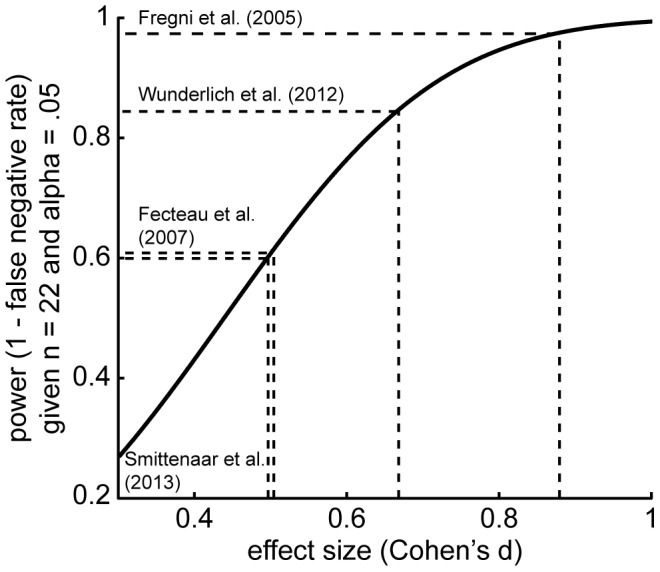
Statistical power to detect true effects.We estimated statistical power in our study based on effect size estimates taken from the published literature. We could then compute the power in our study based on 22 participants and a false positive rate of 0.05 (two-sided alpha). Assuming any true effect of tDCS would have a similar magnitude as the studies shown in the figure, the current study had a power of 50–80%.